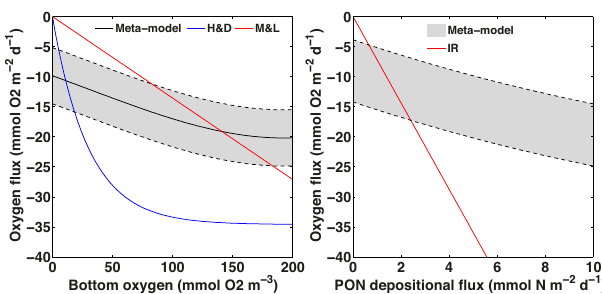
Figure 11. NH + flux in the meta-model compared with that 4 from the IR, H&D and M&L parameterizations. NH + flux is 4 represented as a function of (left) bottom O 2 concentration and (right) PON depositional flux. The grey area and the black line in the left panel correspond to the variation in O 2 flux when 1< F POM <10mmolNm − 2 d − 1 and F POM = 5mmolNm − 2 d − 1 , respectively. The black lines on the right indicate the O 2 flux at bot- tom O 2 concentrations of 0, 50 and 250mmolO 2 m − 3